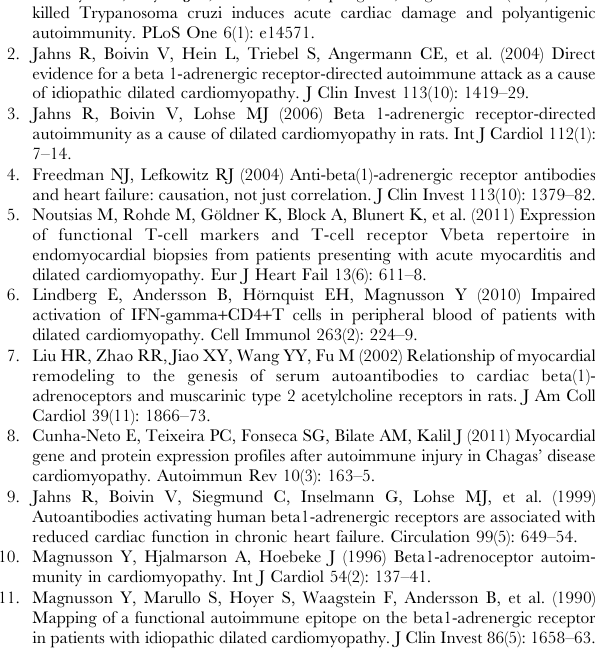
patients (25 m g/ml). Data were presented as means 6 SD of three independent experiments. (TIF) Figure S4 Increases in basal cAMP levels in cultured neonatal rat cardiomyocytes expressing b 1 -AR upon incubation with b 1 -AA. ** p , 0.01 versus vehicle group. n = 6 per group. Data are presented as means 6 SD of 3 independent experiments. Figure S5 Functional assays with b 1 -AA purified from individual DCM patient. A. b 1 -AA from individual DCM patient increased the beat frequency of cultured cardiomyocytes. B. Increases in basal cAMP levels in cultured neonatal rat cardiomyocytes incubation with b 1 -AA from individual DCM patient. ** p , 0.01 versus vehicle group. n = 6 per group. Data are presented as means 6 SD of 3 independent experiments. (TIF) Figure S6 The effects of b 1 -AA on CD3 + T cells prolifer- ation. A . b 1 -AA had no effect on resting rat CD3 + T cells. B, C, D . b 1 -AA enhanced the proliferation of activated CD3 + T cells isolated from b 1 -AA-positive/ 2 negative DCM patients and healthy subjects, respectively. ** p , 0.01 versus vehicle group; ## p , 0.01 versus negative IgG group. n = 6 per group. Data are presented as means 6 SD of 3 independent experiments. (TIF)